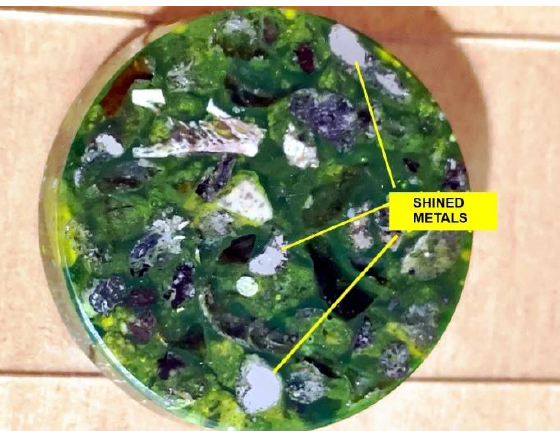
Figure 18. Metallic substance, shiny. SP2 sample, macrophotograph of the polished section prepared for microscopic analysis.